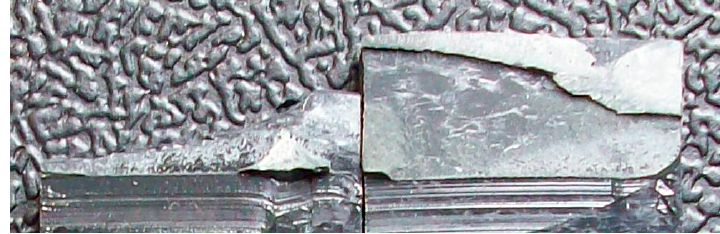
Figure 15. Fracture surface of a specimen pretreated with plasma using D = 5 mm and v = 100 mm/s.